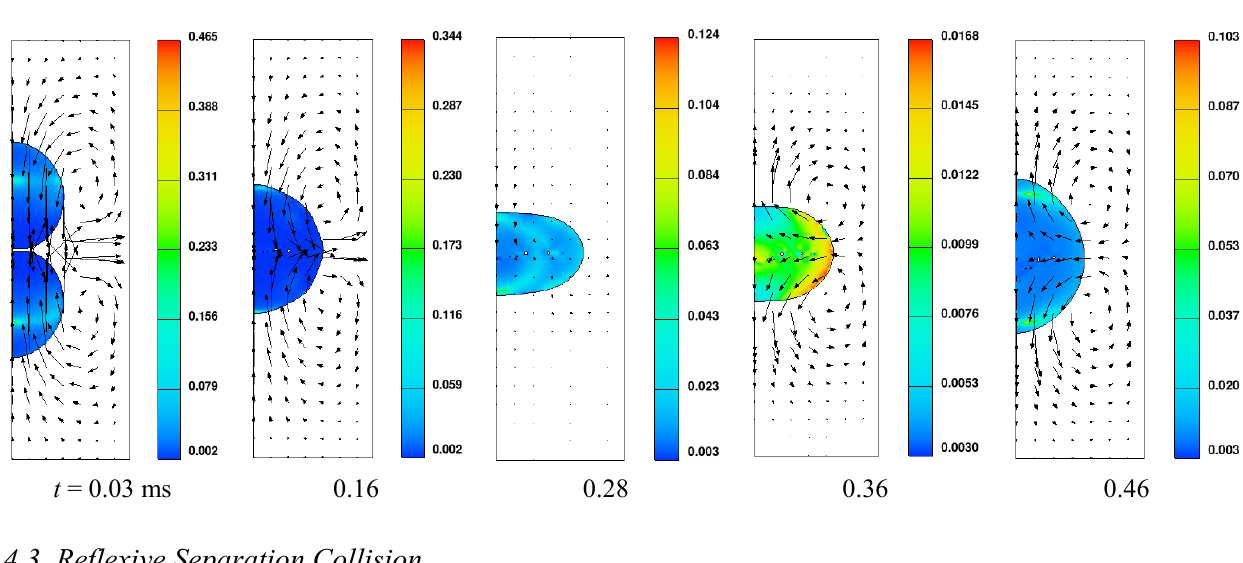
Figure 9. Dynamic viscosity (Pa·s) and velocity field evolution for coalescence collision.